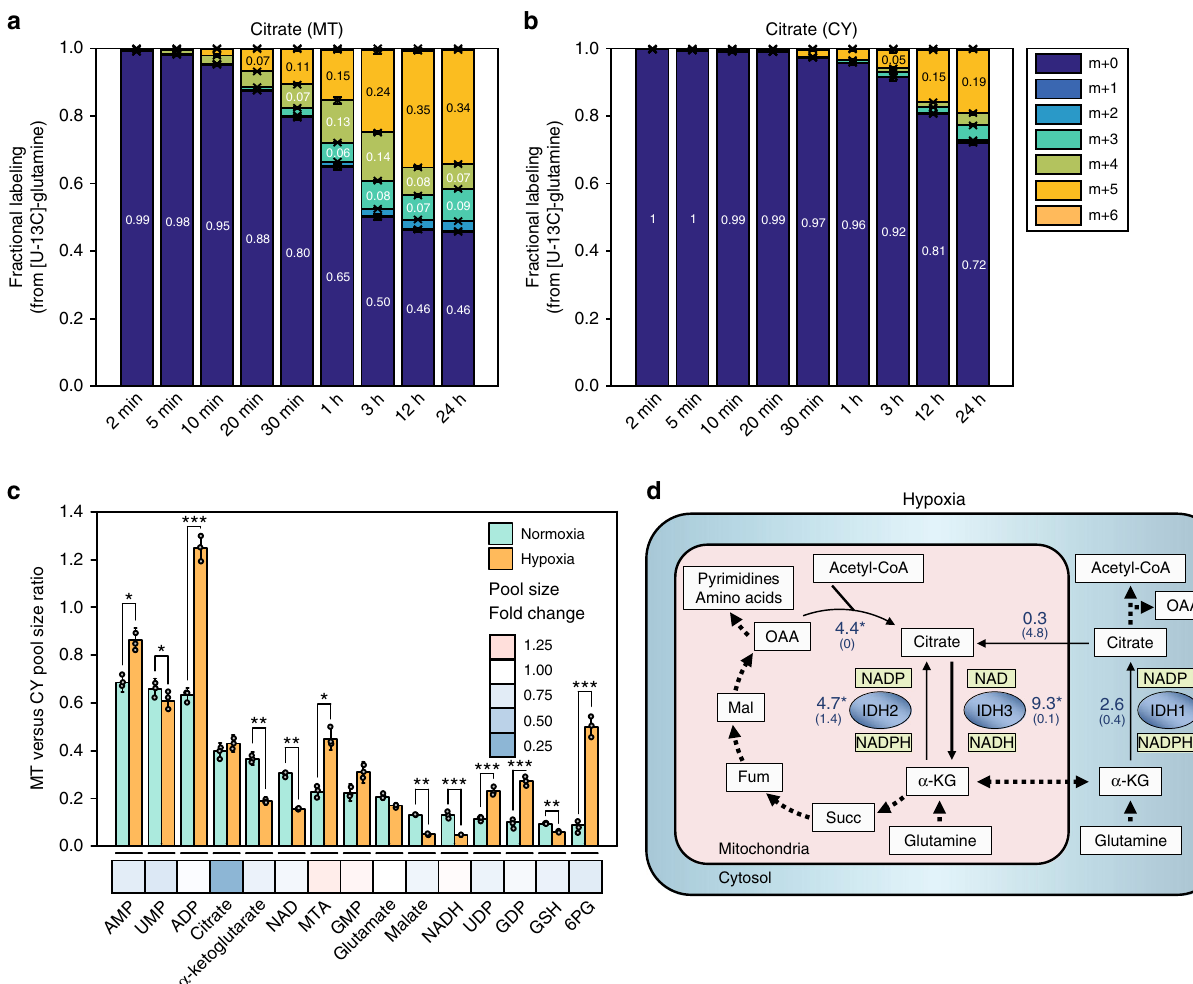
Fig. 4 Metabolic rewiring of mitochondrial and cytosolic fl uxes under hypoxia. a, b Mass-isotopomer labeling kinetics of citrate in mitochondria ( a ) and cytosol ( b ) when feeding HeLa cells with [U- 13 C]-glutamine under hypoxia. c Mitochondrial to cytosolic metabolite pool size ratios ( y -axis) under normoxia (green) and hypoxia (orange) in HeLa cells; average fold change in whole-cell pool size under normoxia and hypoxia is indicated by color ( x -axis). d Mitochondrial and cytosolic fl uxes in HeLa cells under hypoxia, showing percentages from citrate synthase fl ux in normoxia. Arrow represents the direction of net fl ux; number represents net fl ux in the direction of the arrow and number in parenthesis correspond to the backward fl ux. Con fi dence intervals for estimated fl uxes shown in Supplementary Data 8. * P < 0.05, ** P < 0.01, and *** P < 0.001 by two-sample t -test. Data are mean ± SD, n = 3 independent biological